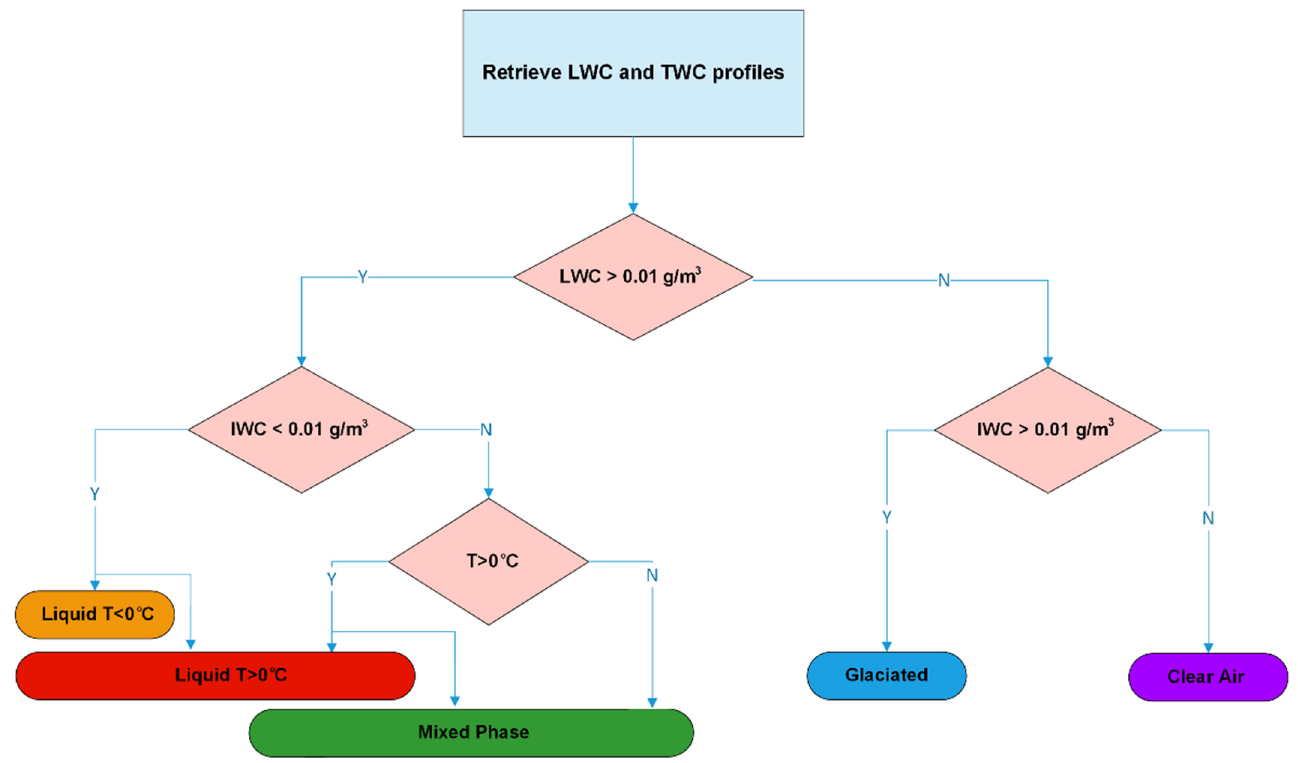
Figure 5. Decision tree illustrating the methodology of the classification based on conditional statements on data from bulk water content and temperature sensors [20]. The full decision tree includes further sub-classification using particle diameters.